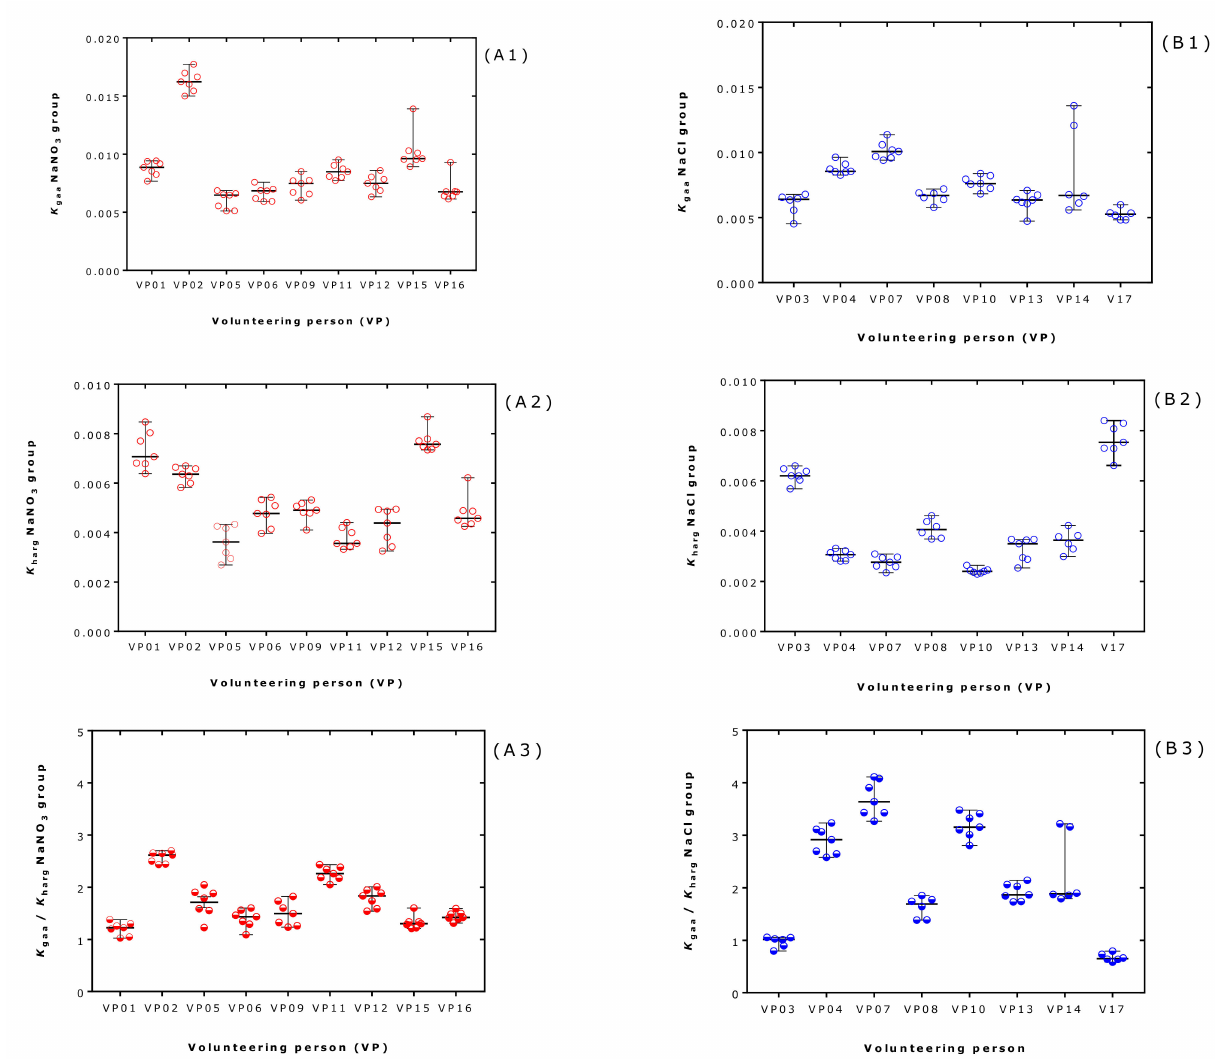
Figure 3. K gaa , K harg , and K gaa / K harg values of the volunteering persons (VP) of the NaNO 3 group ( A1 – A3 ) and of the NaCl group ( B1 – B3 ) at the seven timepoints of exercise after supplementation (see Scheme 2). Data are shown as the median with 95% confidence interval for each volunteer (see also Figure